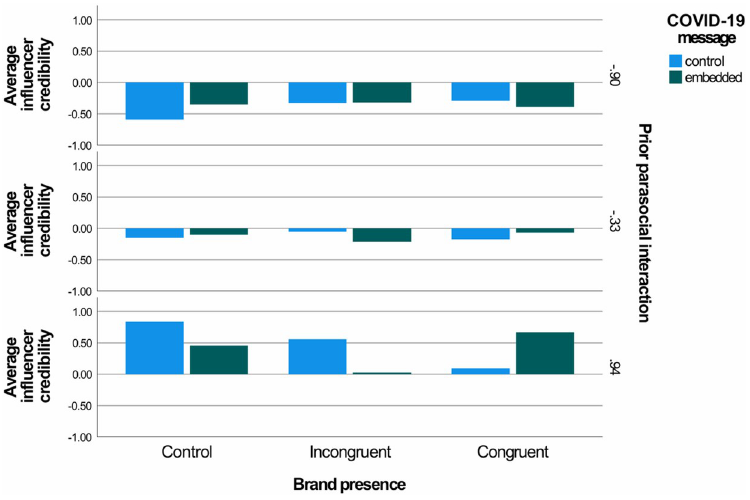
Fig 2. The conditional effect of the brand presence-COVID-19 message interaction at different strengths (weak, moderate, strong) of prior parasocial interaction.